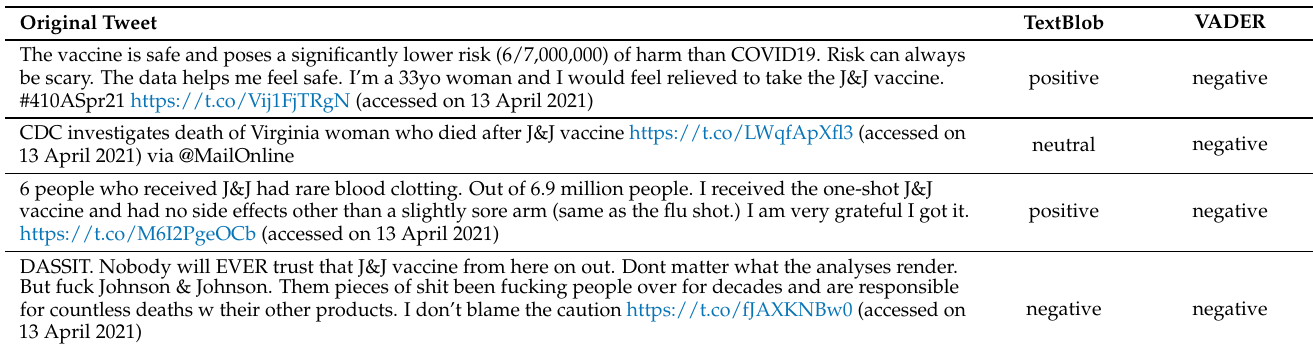
Figure 4. Public Sentiment for different Vaccines with Timeline using VADER Figure 7. Public sentiment for different vaccines with timeline using VADER. Table 4. Tweets on Johnson & Johnson Vaccine on April 13, 2021 Table 5. Tweets on Johnson & Johnson Vaccine on 13 April